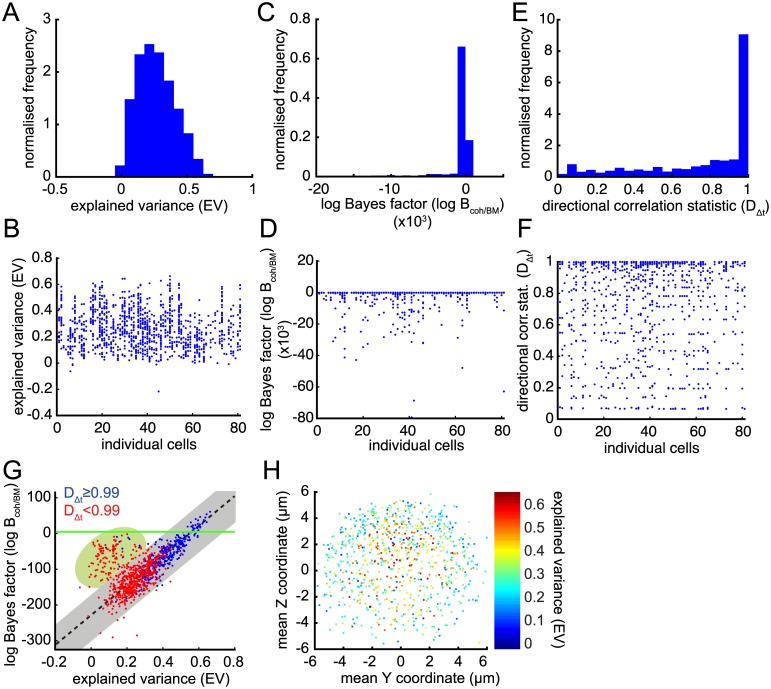
Determination of oscillatory trajectories using three quality statistics.(A) Histogram of explained variance (EV) of each trajectory. (B) Explained variance of each trajectory arranged by cell. (C) Histogram of log Bayes factor of the kinetochore model M
coh against Brownian motion M
BM (log B[M
coh/M
BM]) of each trajectory. (D) log B[M
coh/M
BM] of each trajectory arranged by cell. (E) Histogram of directional correlation statistic D
Δt of each trajectory. (F) D
Δt of each trajectory arranged by cell. (G) log B[M
coh/M
BM] plotted against EV for each trajectory. Trajectories are coloured according to D
Δt; blue have significant directional correlations. (H) Mean trajectory positions within the metaphase plate viewed along the spindle axis (Y, Z) coloured by EV. All converged trajectories are shown in panels (A-G) (n = 1169); only those from grey area in (G) are shown in (H) (n = 843).